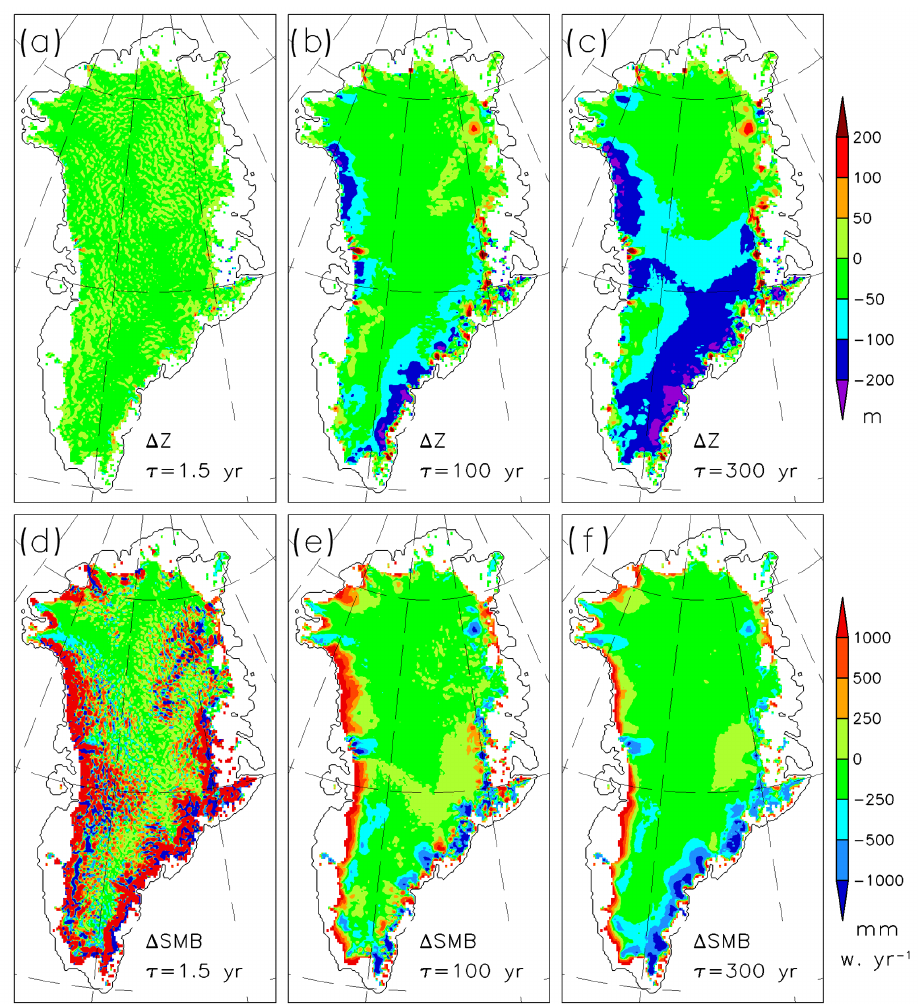
Figure 6. Differences between simulated and observed present-day 2-D fields for various relaxation constants, i.e. 1.5, 100 and 300 years. Panels (a) , (b) and (c) : deviation of surface elevation from observed. Panels (d) , (e) and (f) : deviation of our implied SMB from the SMB from the regional model